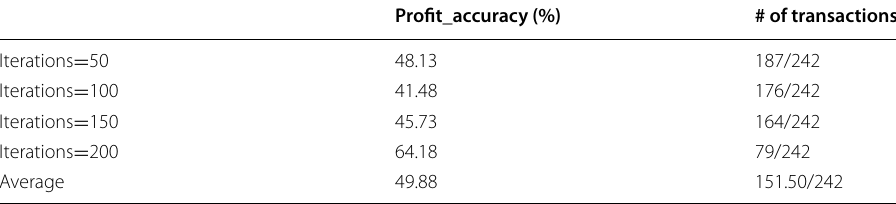
Profit_accuracy (%) # of transactions